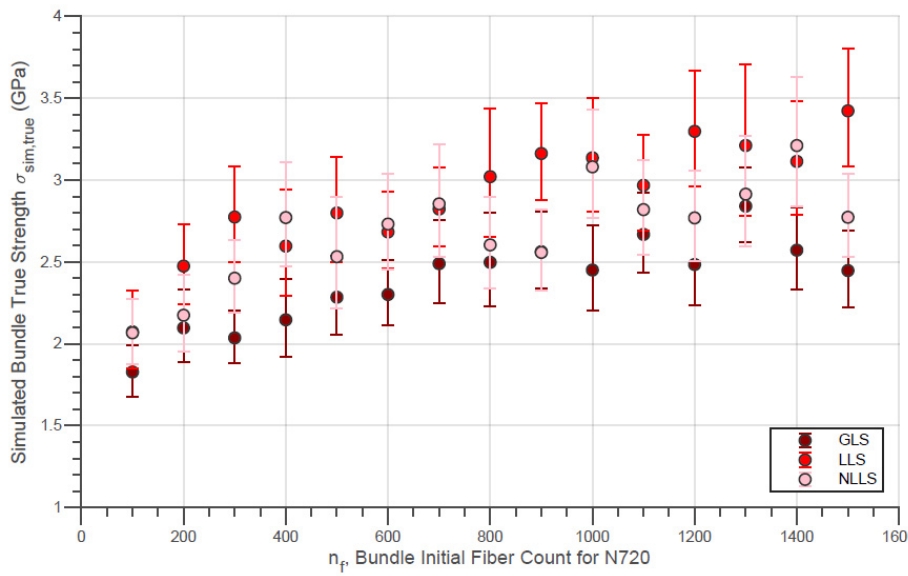
Figure 13. Simulated Characteristic Bundle True Strength against Initial Fiber Count for 720 Fiber Bundles using different load-sharing models.